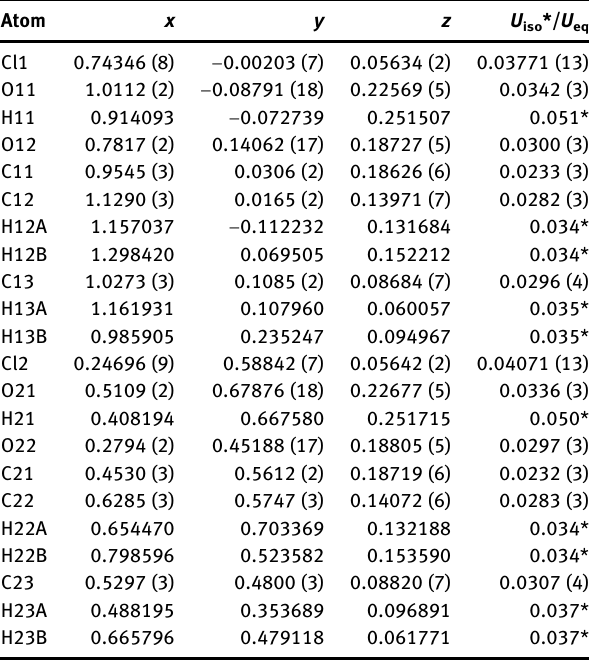
Table  : Fractional atomic coordinates and isotropic or equivalent isotropic displacement parameters (Å 